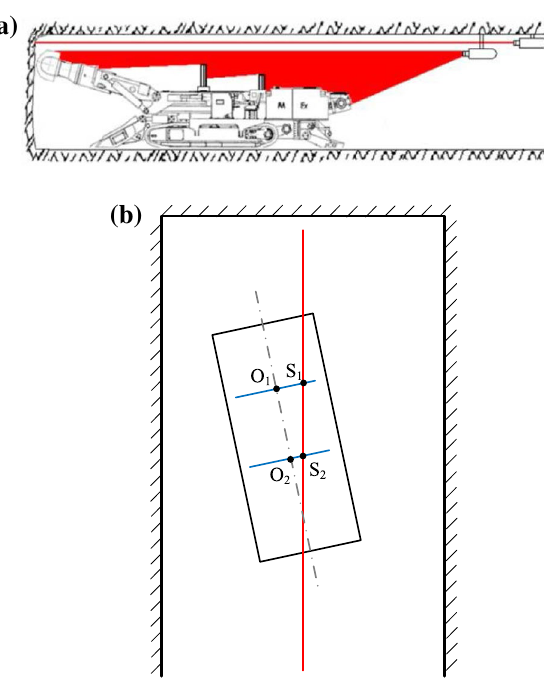
Fig. 17 Schematic diagram of measurement principle of the devia- tion angle. ( a ) Emitting and receiving of the fan-shaped laser; ( b ) Calculation of the deviation angle